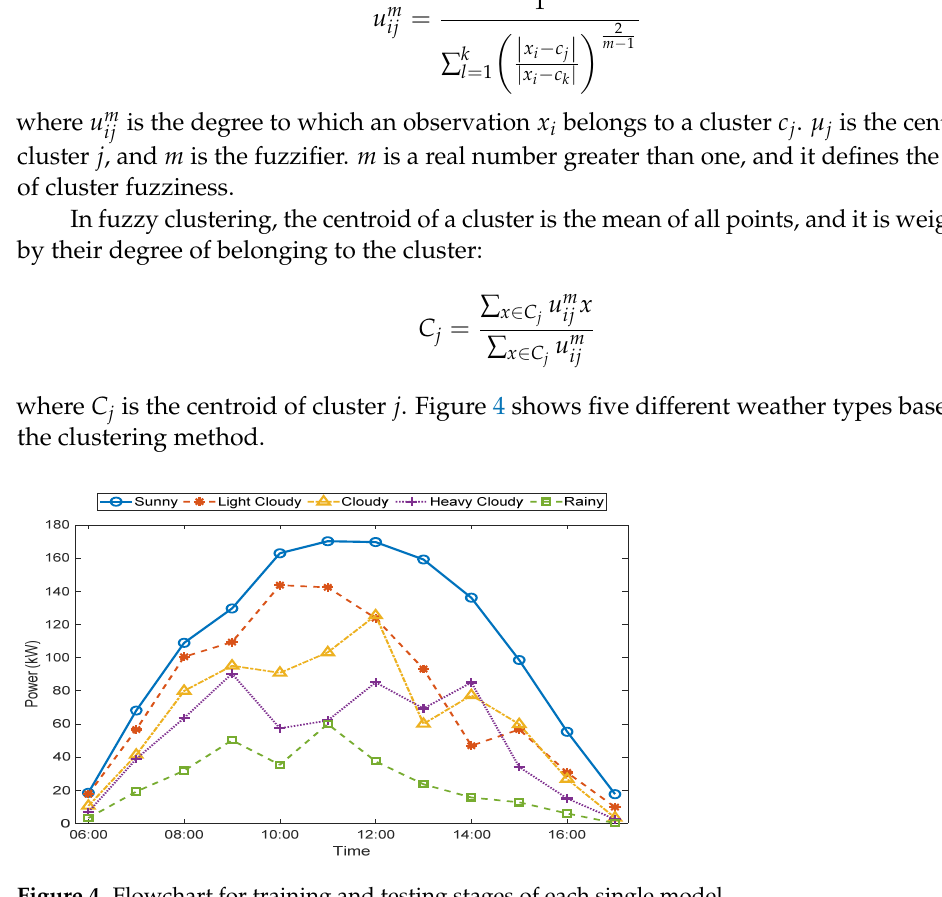
Figure 4. Flowchart for training and testing stages of each single Figure 5. PV power output for five different weather types.